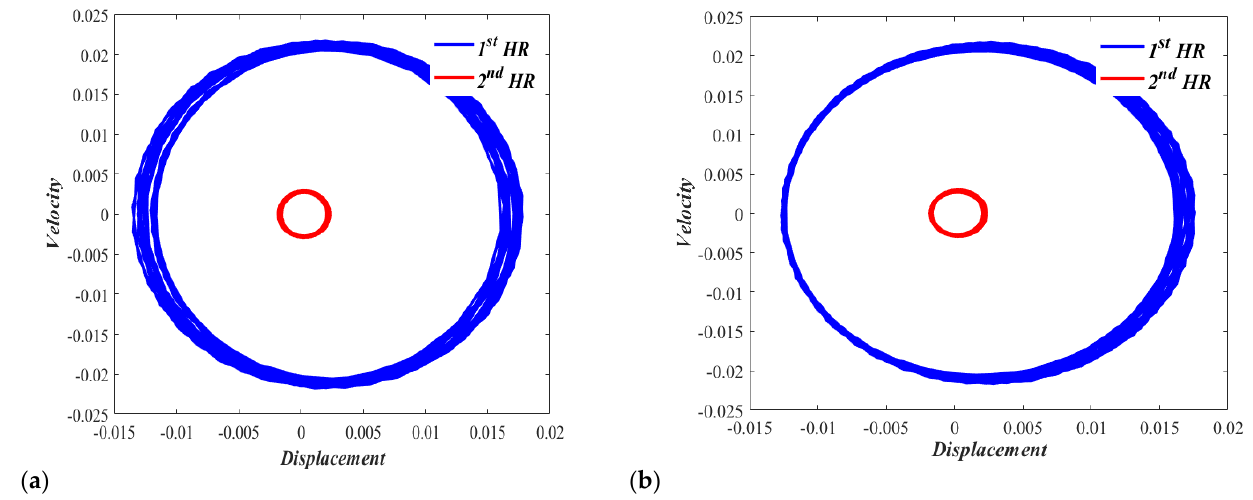
Figure 9. Phase portrait for the nonlinear dual HR excited by p = 150 dB, ( a ) Ω = 0.47, and ( b ) Ω = 1.57.